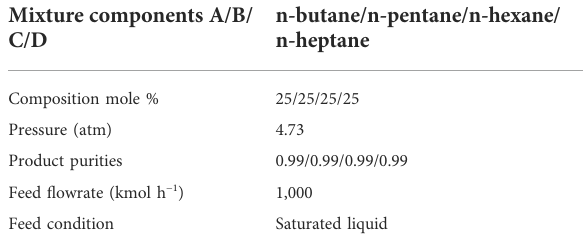
TABLE 6 Computational performance for Example 2. TABLE 7 Feed conditions for Example